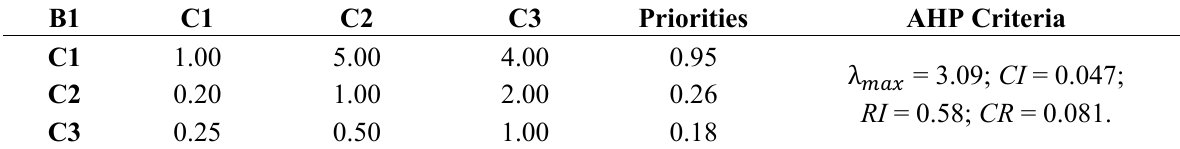
Table 3. Judgment matrix of the criterion B1 and its related factors.